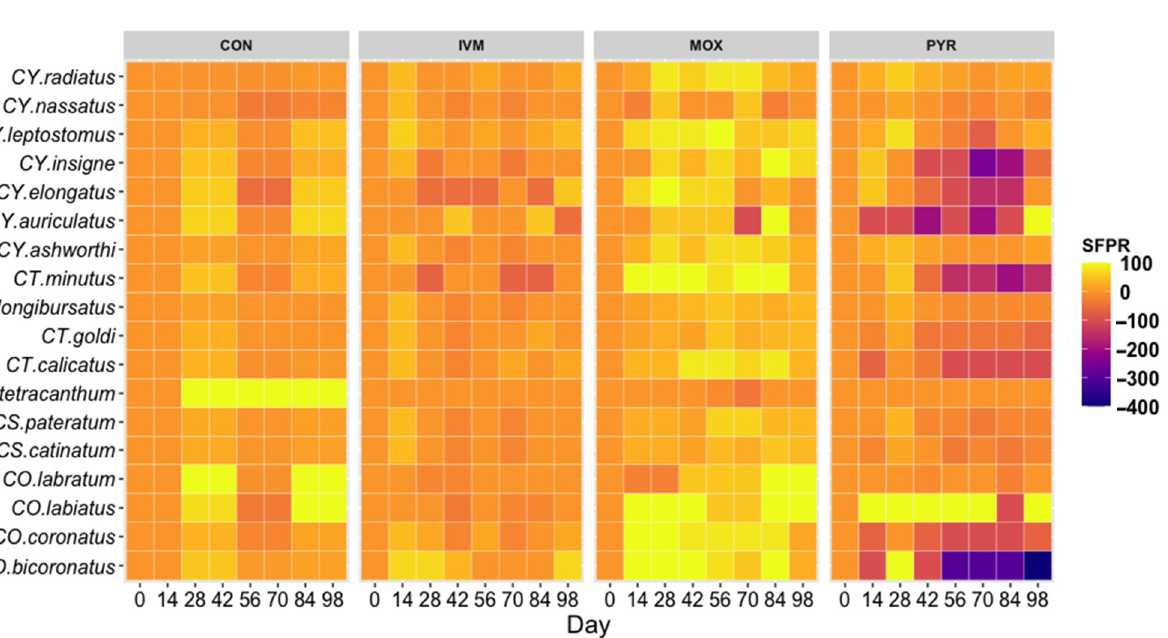
(Figure 1). IVM reduced species infection rates for 11 species at 14 d post-treatment, but a 100% reduction in any species was not observed, as was achieved by MOX and PYR (Figure 1). Cyathostomin species treated with IVM returned to 0 d infection rates or greater by 28 d in all species except for CY. leptostomus (42 d), CO.coronatus (42 d), and CD. bicoronatus (56 d). The extended period of CD. bicoronatus reduction may be a factor of Table 4. ANOVA and Spearman correlations based on frequency of presence. environmental and natural species patterns of the region as reflected in the CON group. Spearman Correlation MOX was able to achieve 100% reduced SFP rates in four species 14 d post-treatment ( CT. p -Value (r) minutus, CO. labiatus, CO. coronatus, CD. bicoronatus ) and continue to reduce rates for at least four weeks. Five species ( CY. leptostomus, CY. insigne, CY. elongatus, CY. auriculatus, and CS. catinatum) were reduced by 100% at later time points but were able to reinfect horses more quickly than the four species showing more sensitivity toward MOX (Figure